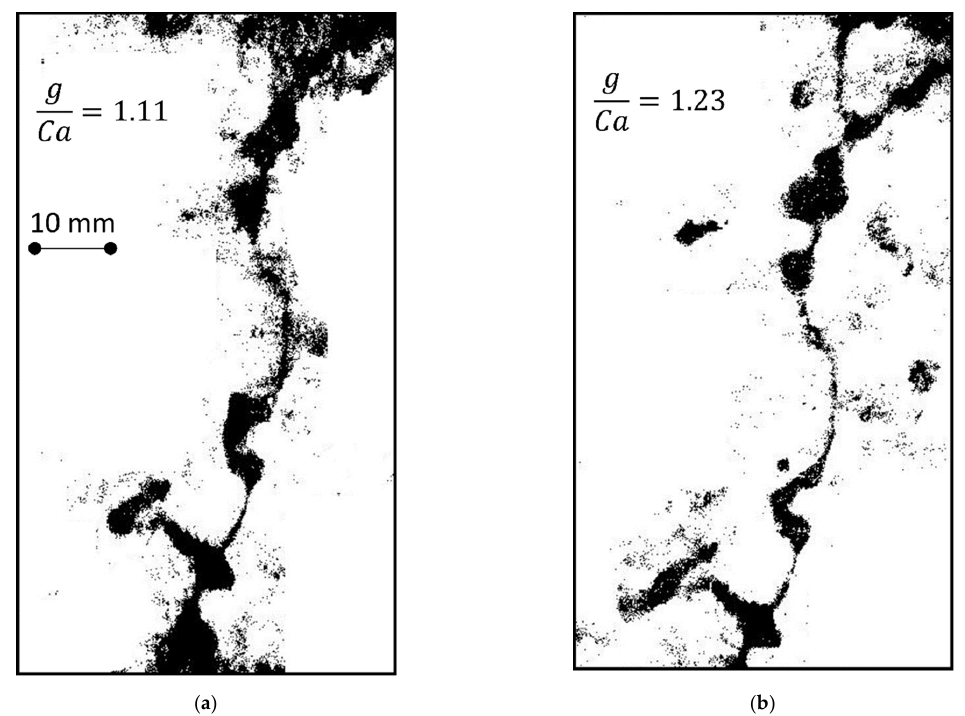
Figure 8. Shape of the first flow path in Fracture-1 under dry initial condition at varying the inclination angle; ( a ) β = 55°; ( b ) β = 65°.